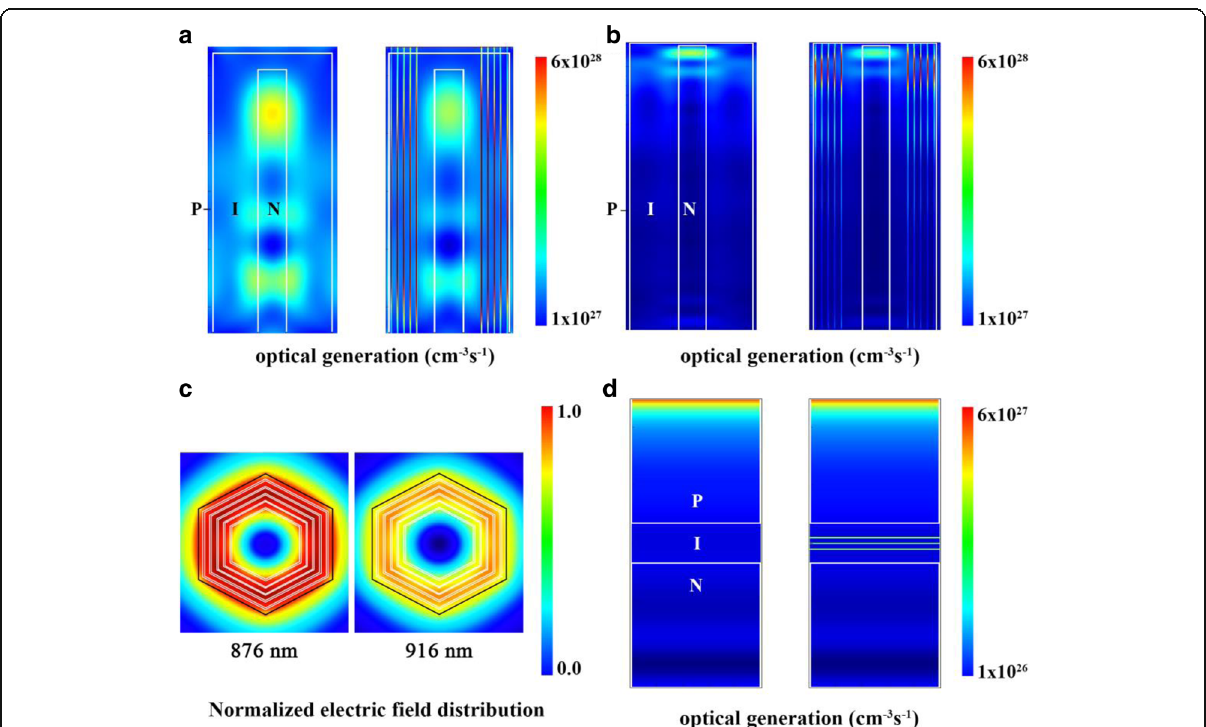
Fig. 4 a The vertical cross section of optical generation profiles in short NW and NW/QD hybrid solar cells. b The vertical cross section of optical generation profiles in long NW and NW/QD hybrid solar cells. c The electric field distributions in NW cross section at 876 and 916 nm, in which the location of QD layers is marked out with white lines. d The vertical cross section of optical generation profiles in thin-film and thin-film/QD hybrid solar